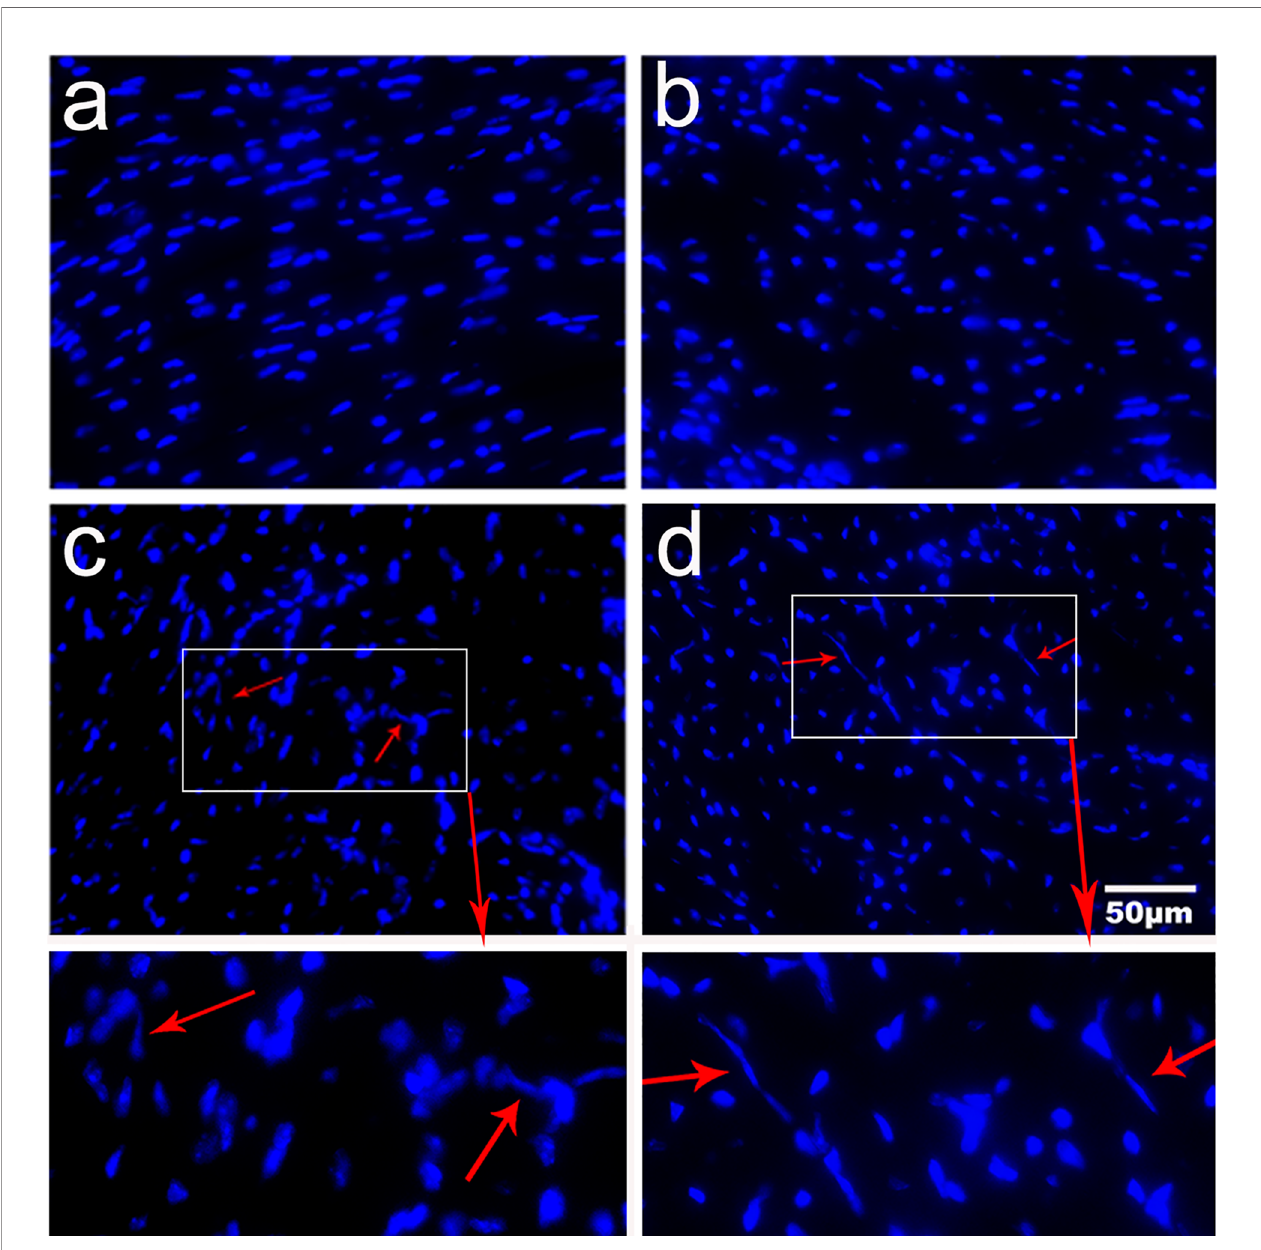
FIGURE 5 | Expression of extracellular traps in the heart tissues of different groups of mice. Fluorescence staining showed no extracellular trap in uninfected mice (a) and uninfected mice with a -lactose treatment (b). In fl ammatory cells released DNA extracellular traps (red arrows) were observed in the heart tissues of T. spiralis - infected mice (c) and T. spiralis -infected mice with a -lactose treatment (d). Original magni fi cation 400× (scale bar = 50